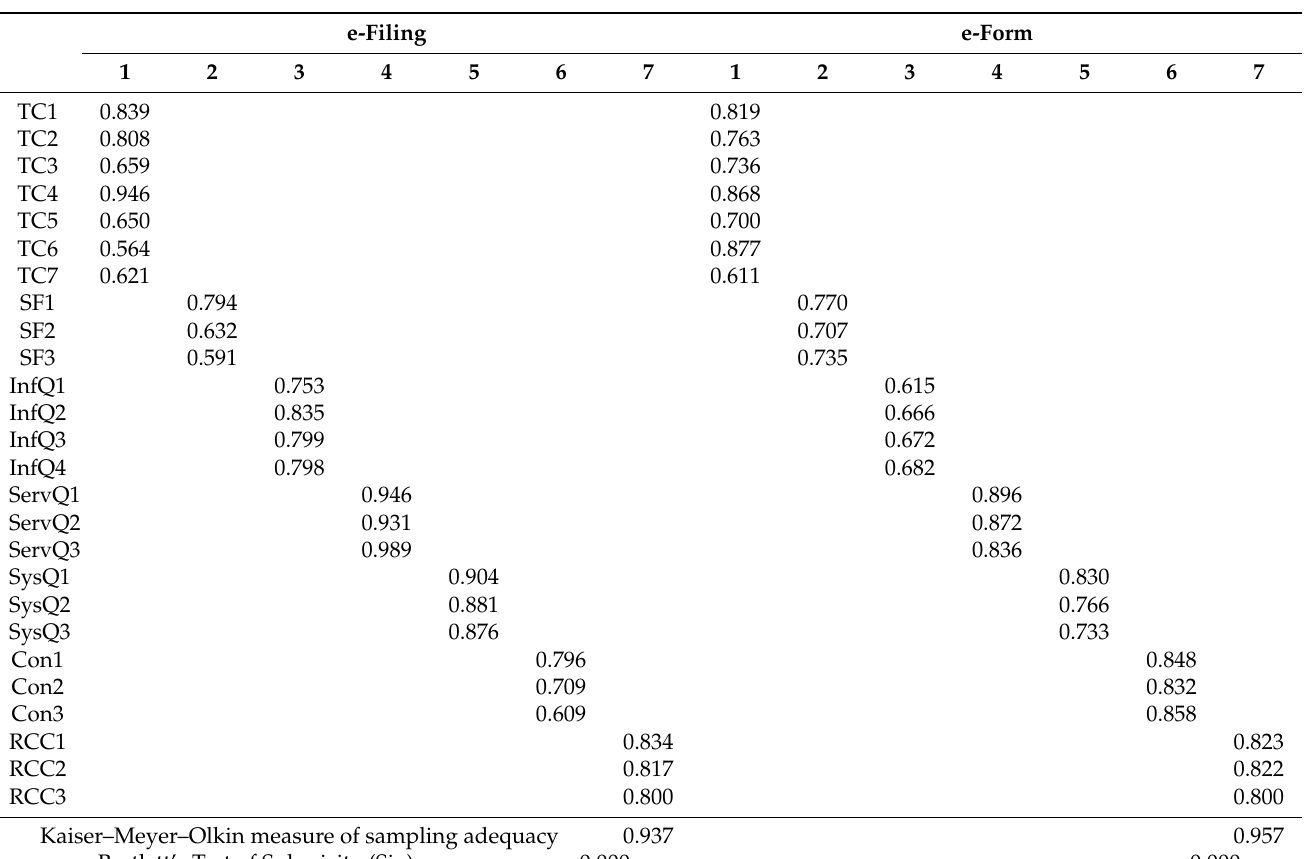
Table 3. Factor loading.